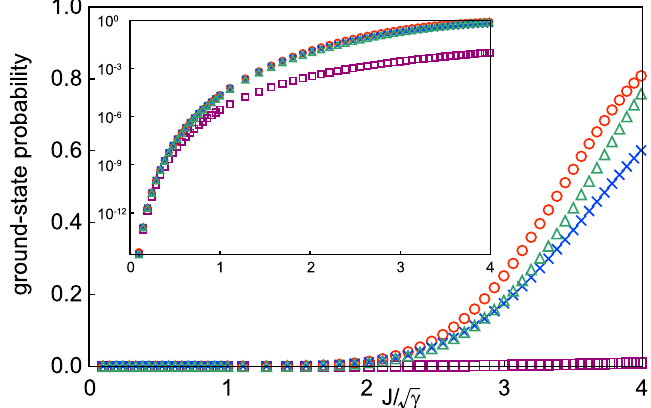
Figure 3: Ground-state probability. Plotted are numerical calculation for ˆ H with ˆ Z in Eq. (48) ( (cid:3) , purple), numerical calculation for ˆ H 0 Eq. (52) ( (cid:13) , red), zeroth order approximation in Eq. (46) ( × , blue), and estimation by Eq. (53) ( (cid:52) , green). We set N = 10. (Inset) Logarithmic